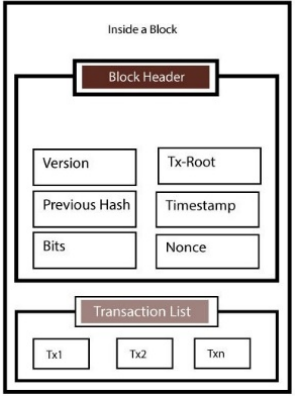
Figure 4. Structure of a block [23].